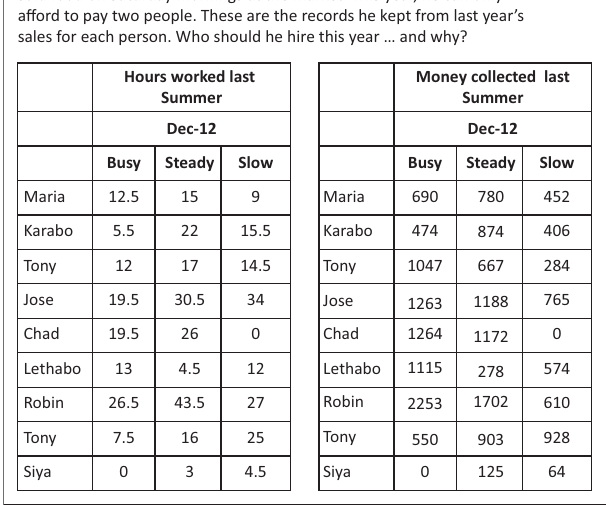
FIGURE 2: An example of a modelling